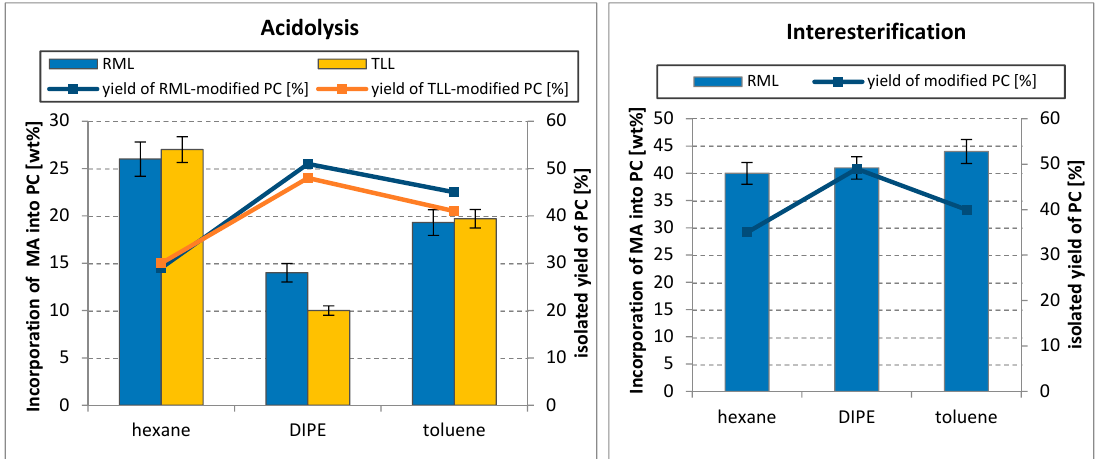
Figure 4. Effect of organic solvent on the incorporation of myristic acid into egg-yolk PC and isolated yield of modified PC in acidolysis and interesterification (reaction condition: temperature, 50–52 °C; PC/acyl donor molar ratio, 1/3; lipase dosage, 30%; 48 h). DIPE—diisopropyl ether.